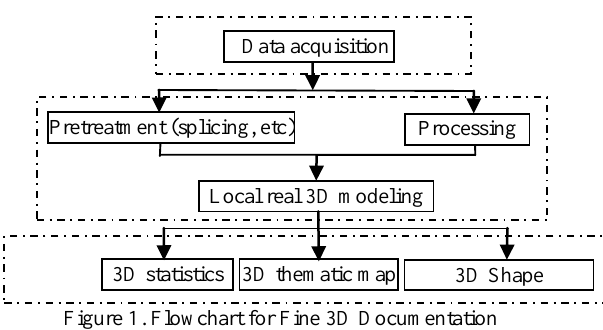
Figure 1. Flowchart for Fine 3D Documentation